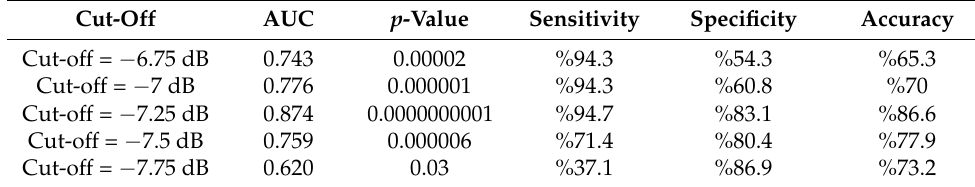
Table 1. Defining a cut-off value for samples.